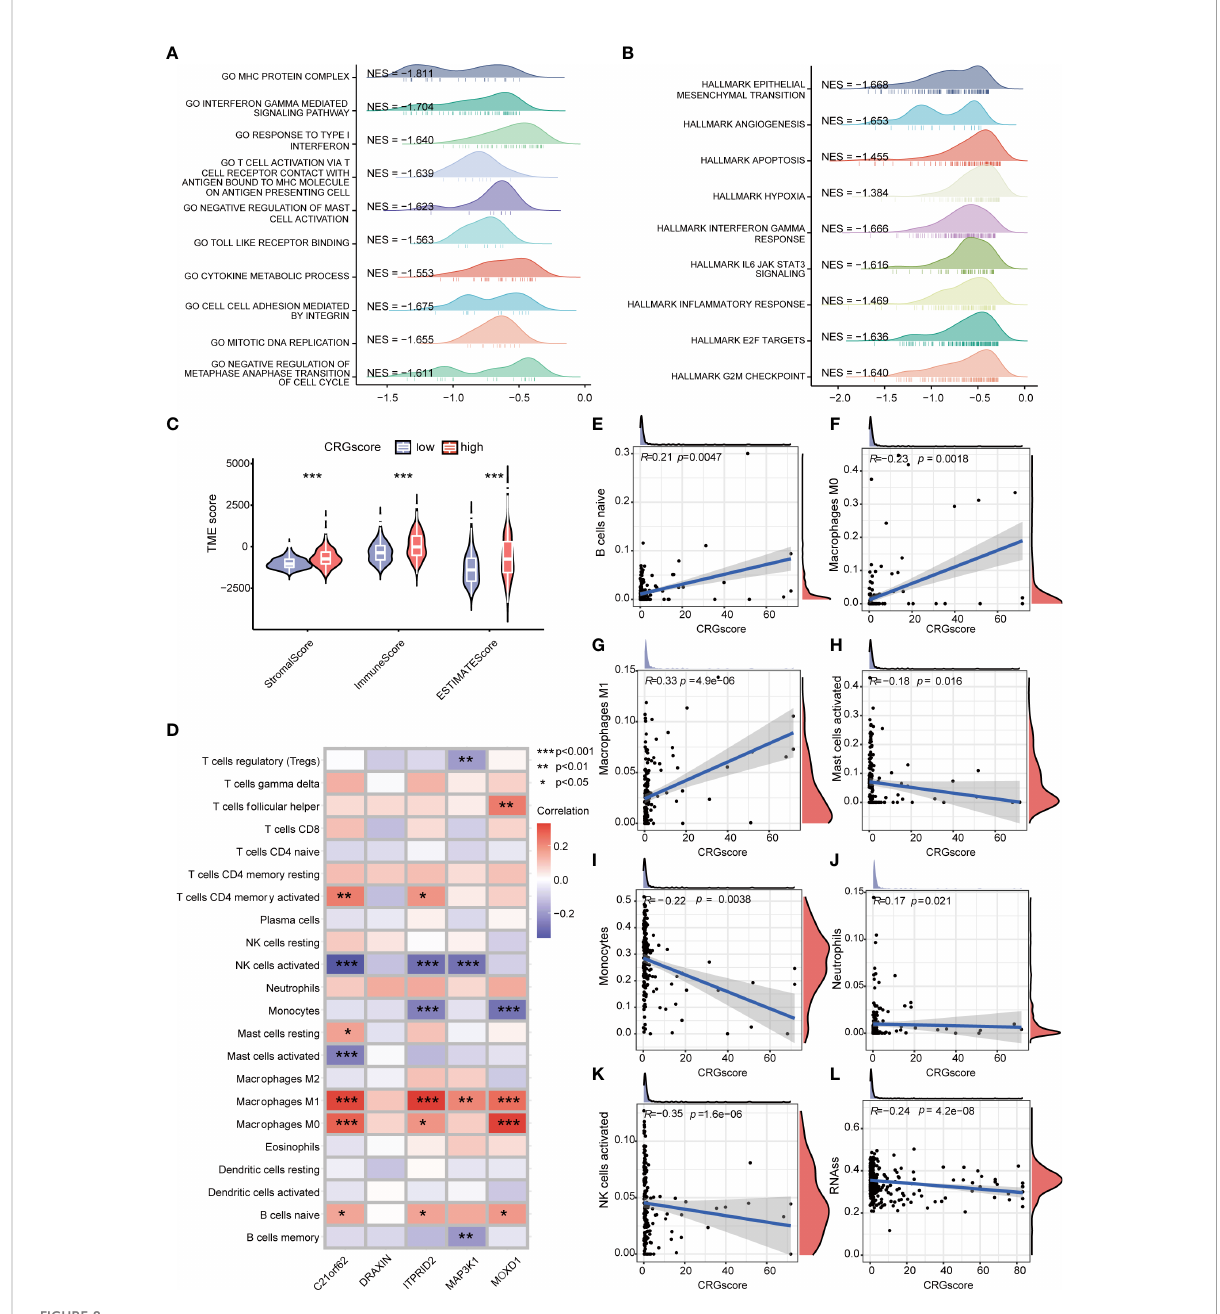
FIGURE 8 Correlations of the CRG score with immune in fi ltration and the cancer stem cell (CSC) index in LGG. (A) GSEA of signi fi cant GOBP terms enriched in the high-risk group. (B) GSEA of signi fi cant HALLMARK terms enriched in the high-risk group. (C) Correlations between CRG scores and TME scores. (D) Correlations between the abundance of immune cells and fi ve genes in the cuproptosis-related prognostic model. (E – K) Correlations between the abundance of immune cells and the CRG score. (L) Correlations between the CSC index and the CRG score. P - values were shown as: * P <0.05; ** P <0.01; *** P <0.001. CRGs, cuproptosis-related genes; CSC, cancer stem cell; LGG, lower-grade glioma (WHO II and III); GSEA, gene set enrichment analysis; GOBP, gene ontology biological process; TME, tumor